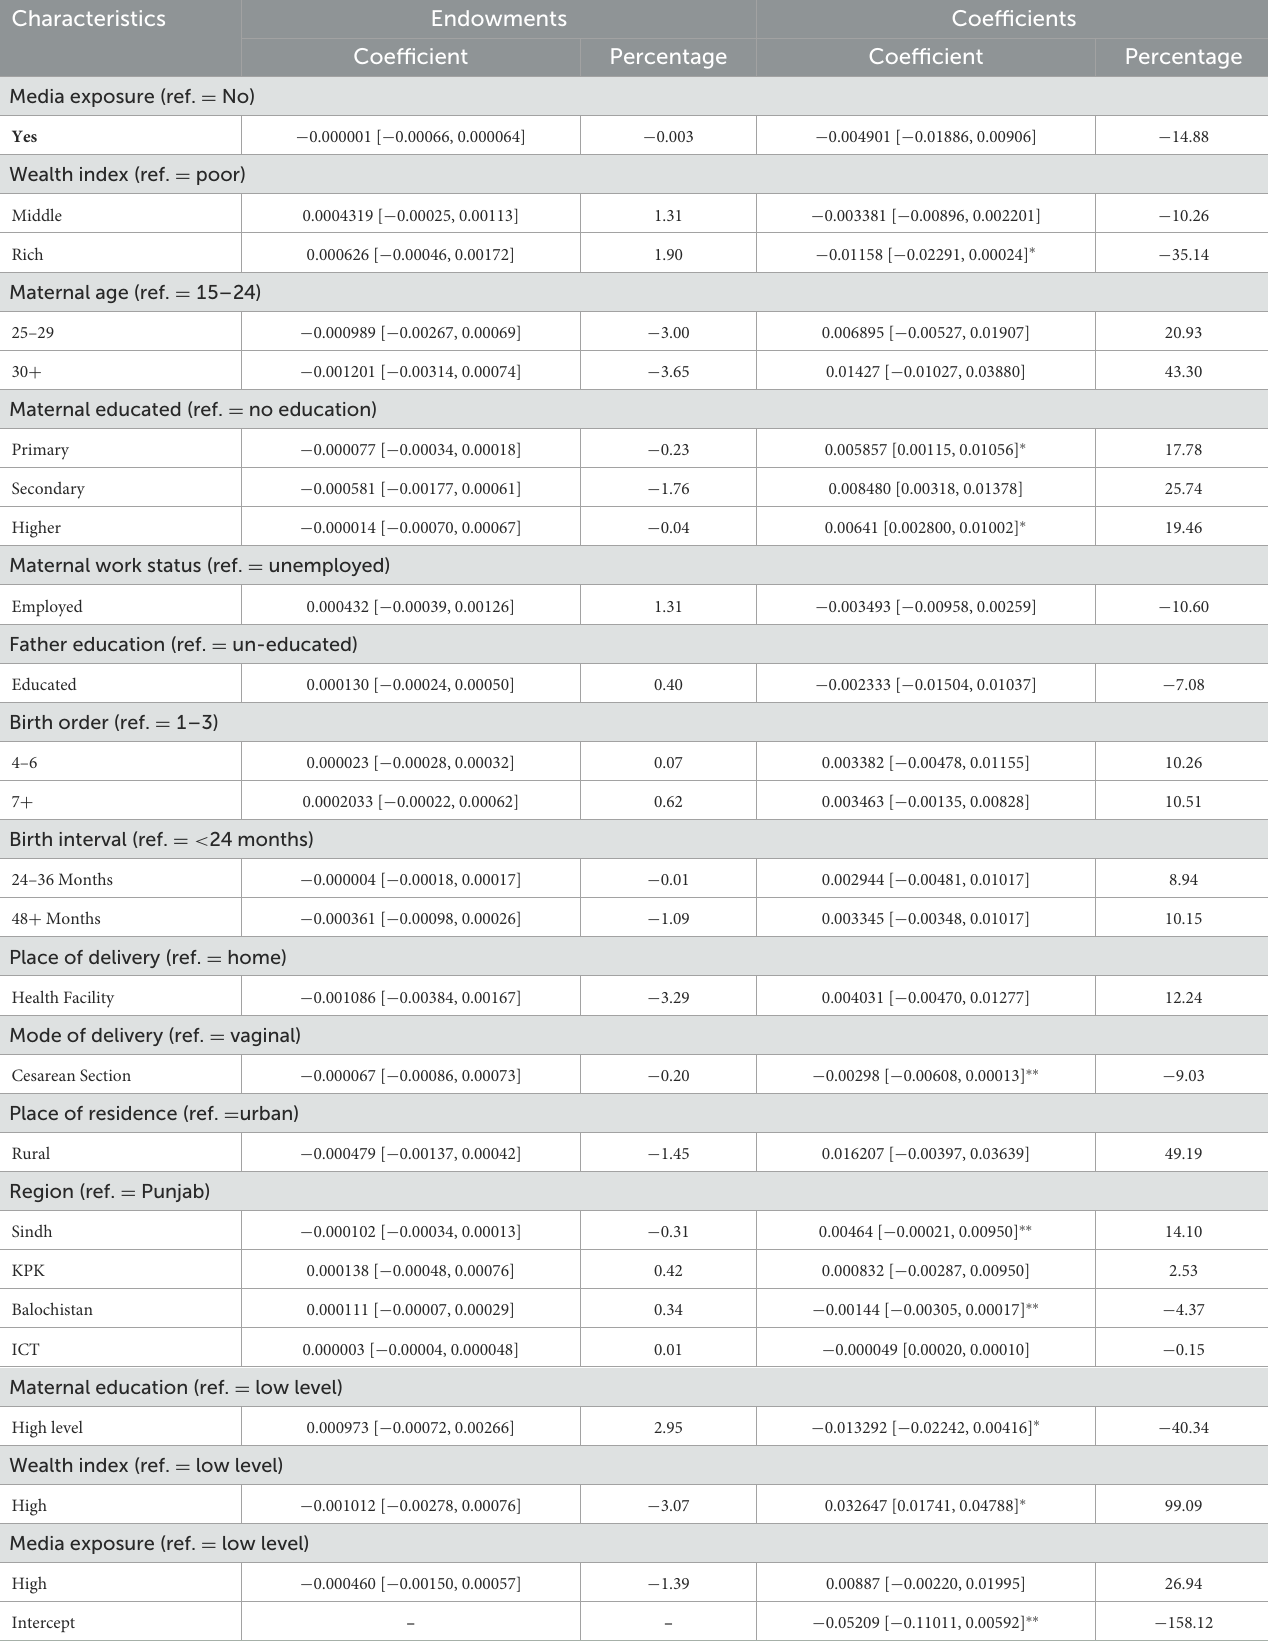
TABLE 4 Details of multivariate decomposition of factors differences in stillbirths, PDHS from 2012 to 2013 and 2017 to 2018.